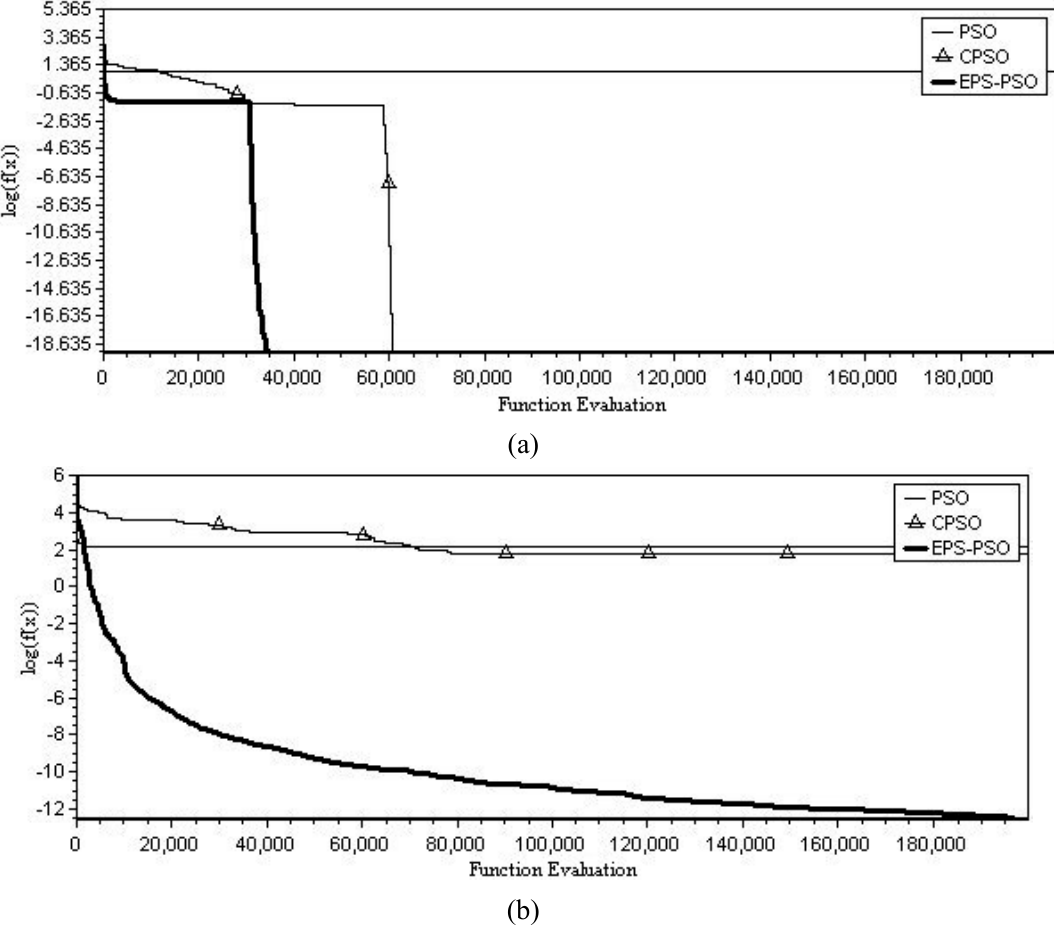
Figure 6. The best convergence results versus function evaluation among 50 independent runs for Rastrigin ( 4 f ): ( a ) unrotated case, ( b ) rotated case.